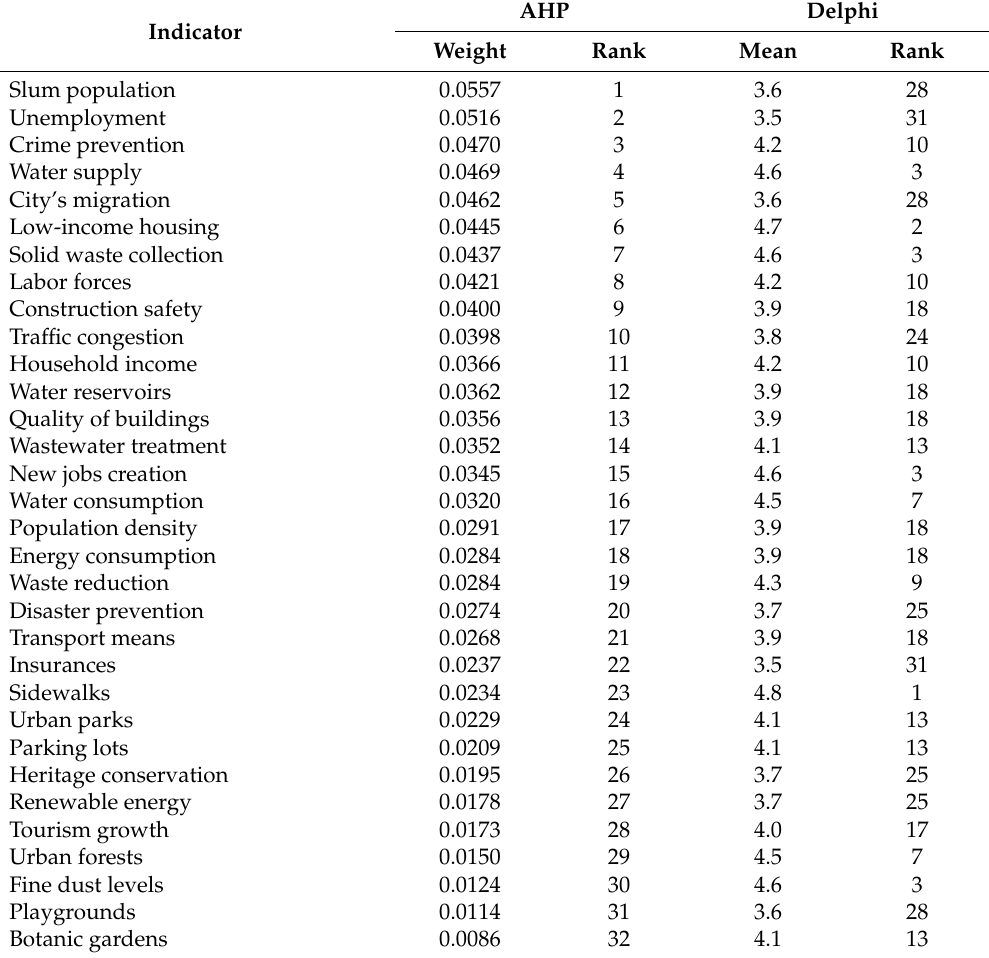
Table 7. AHP’s and Delphi’s ranks of the 32 assessment